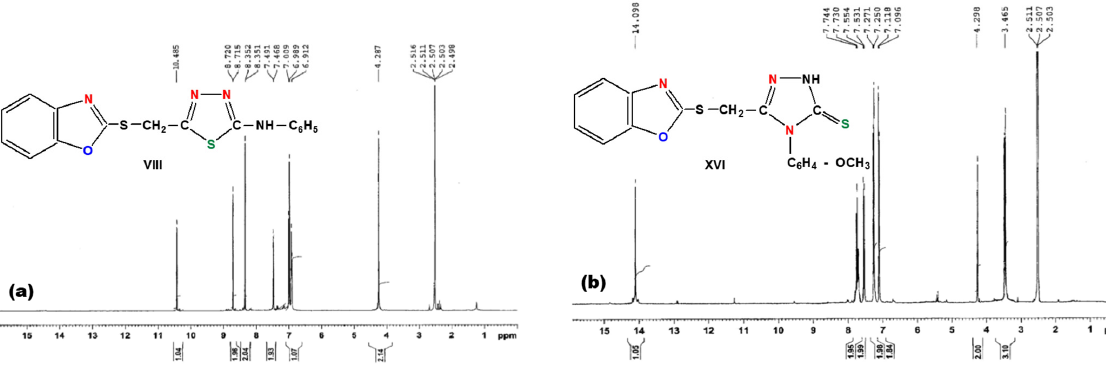
Figure 8. 1 H-NMR spectra of ( a ) 1,3,4-thiadiazoles (compound VIII) and ( b ) 1,2,4-triazoles (compound XVI).